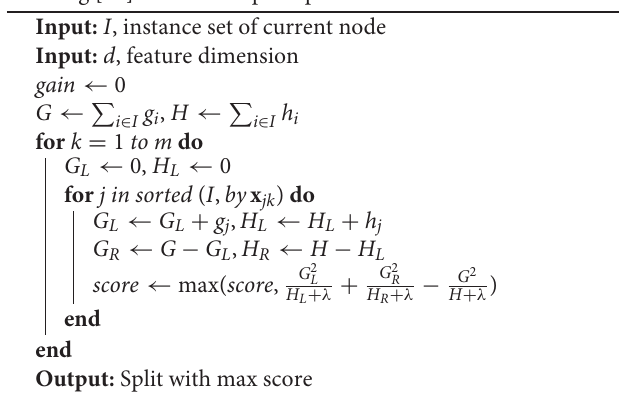
Algorithm 1: Exact greedy algorithm for split